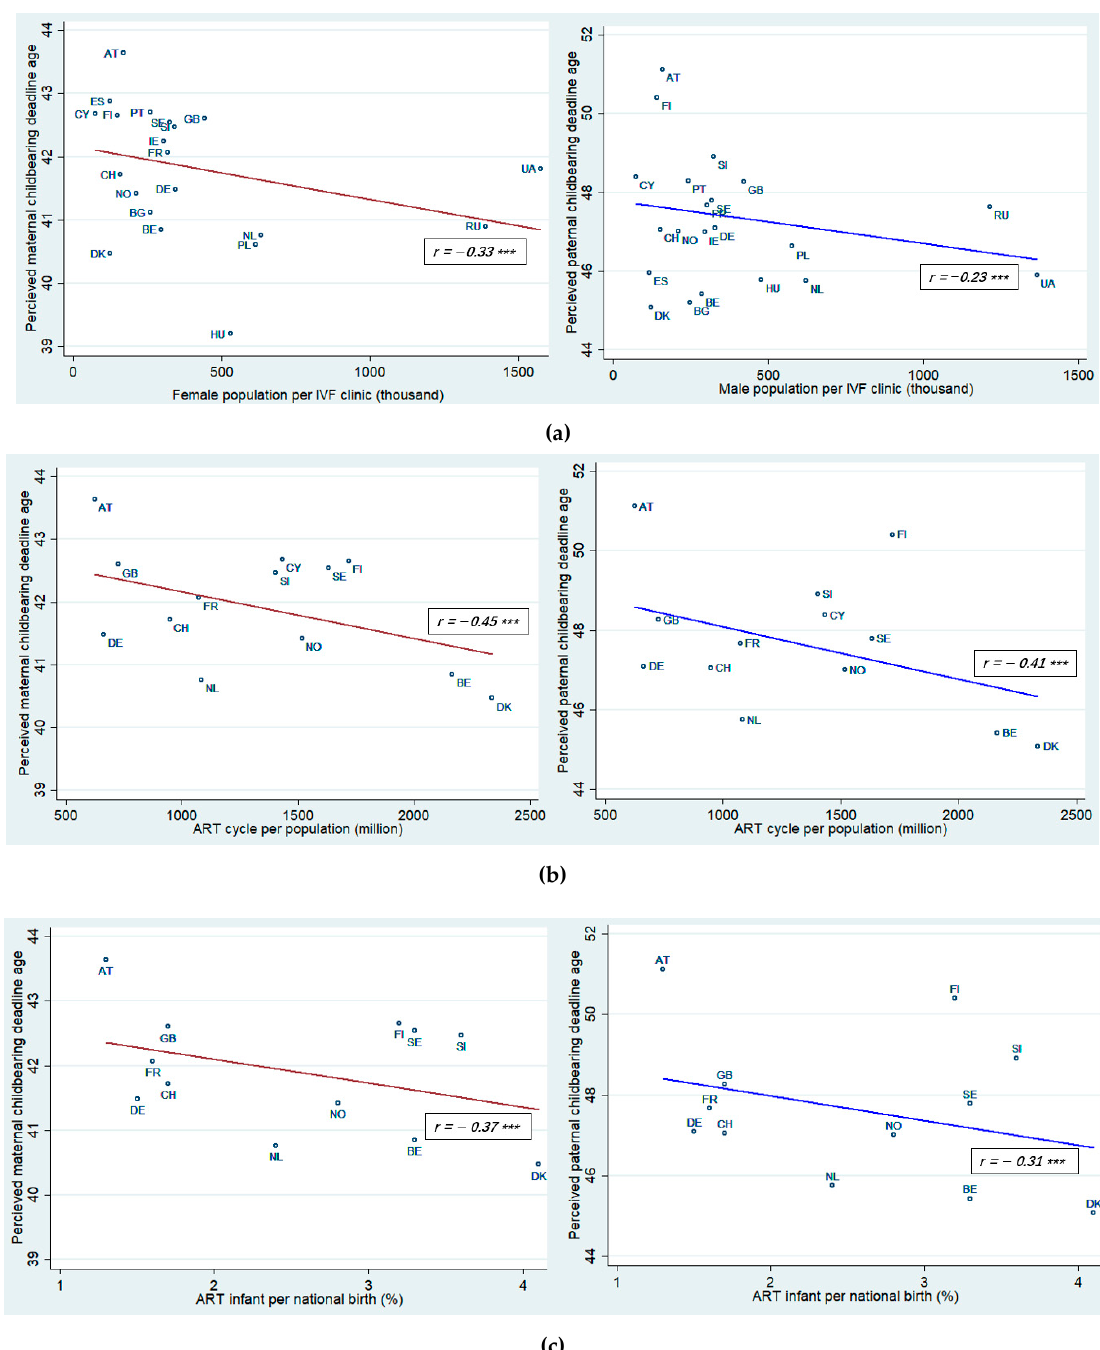
Figure 1. ( a ) Association between social perception of maternal and paternal childbearing deadline ages and availability of IVF clinics; ( b ) Association between social perception of maternal and paternal childbearing deadline ages and ART cycle; ( c ) Association between social perception of maternal and paternal childbearing deadline ages and ART. Pearson correlation ( r ) was conducted to examine the bivariate relationship (*** p < 0.001). See Appendix B for the list of country abbreviations.